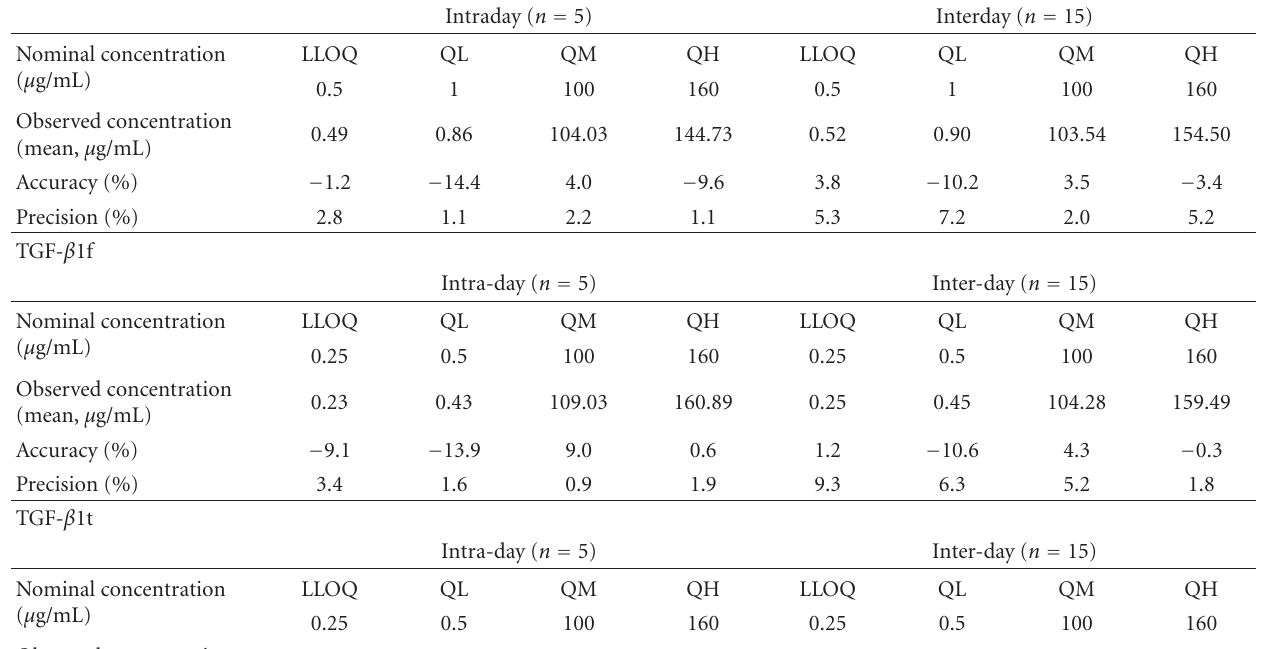
Table 2: Intra-day and inter-day accuracy and precision of QC samples for PI polyamides in rat plasma. HN.49 Intraday ( n =